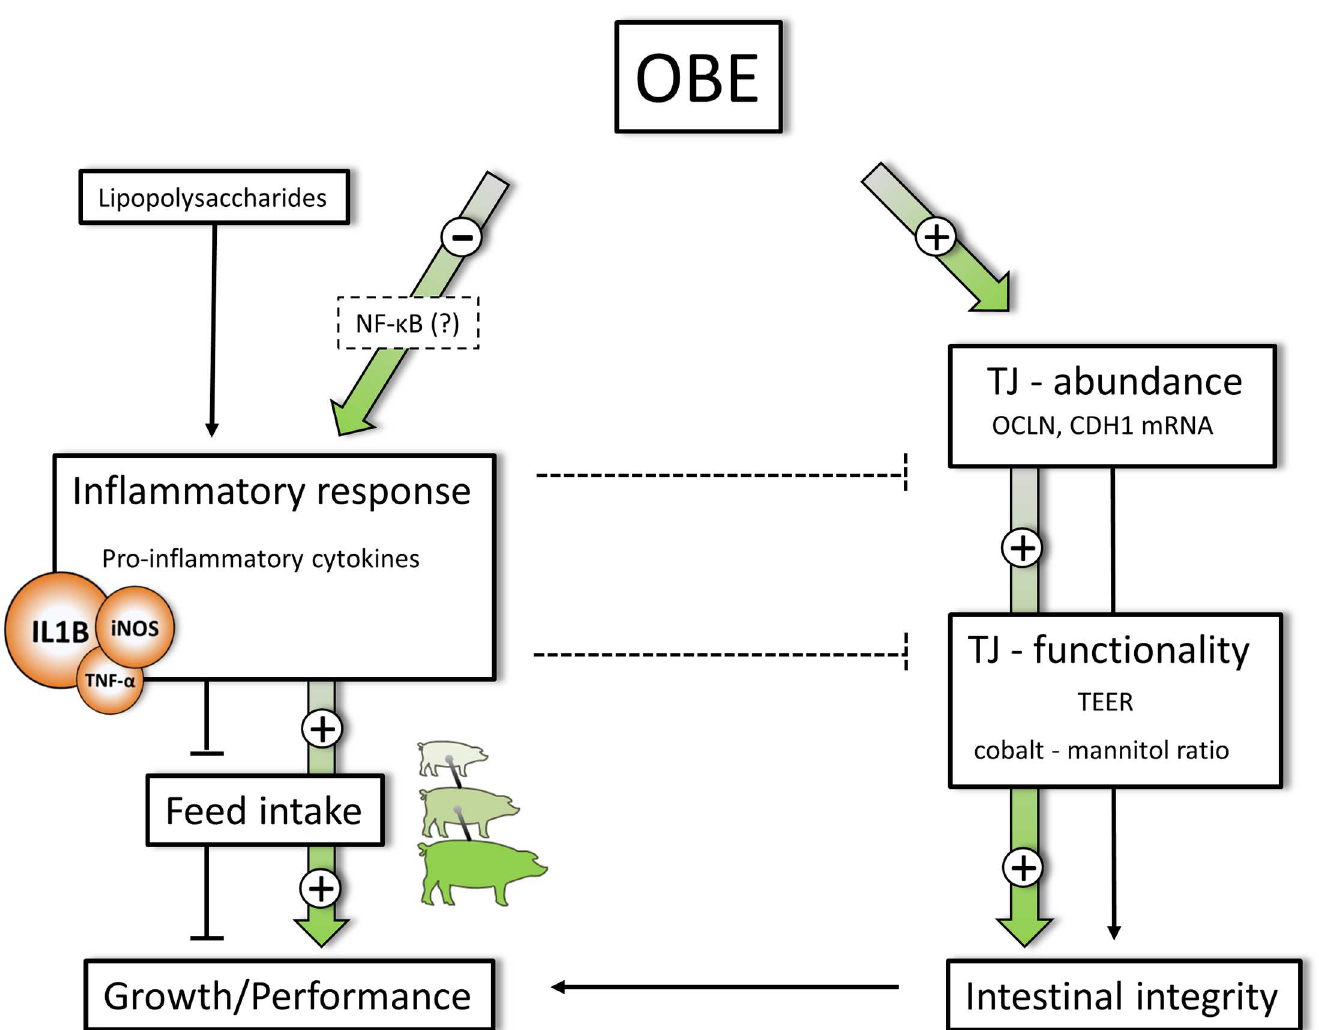
Fig 7. Supposed metabolic targets involved in OBE mediated effects. RepeatedLPS injectionstimulates the systemic secretionof pro-inflammatory IL1B and simultaneously suppressesfeed intake and growth in challenged animals. OBE is capableof counteracting LPS stimulatedIL1B secretionmost likely through interaction with NF- κ B signalcascade. OBE treatment further increasesthe concentration of junctionalmRNA (OCLN, CDH1, ZO-1) and promotes TJ-functionality as indicatedby decreased ion flux (TEER) and improvedcobalt to mannitolratio. Increasedgene expressionof junctional proteinsas well as an improvedTJ-functionality can be linked to enhanced gut integrity, further supportinganimalgrowth and performance. Particular importance is devoted to the finding that the growth promotingeffect of OBE is mediatedindependentof changesin gut microbialcomposition and diversity. Plain connections represent observed(solid) and supposed(interrupted) metaboliceffects of chronic LPS challenge. Colour-filledarrows indicateeffects of OBE treatment.